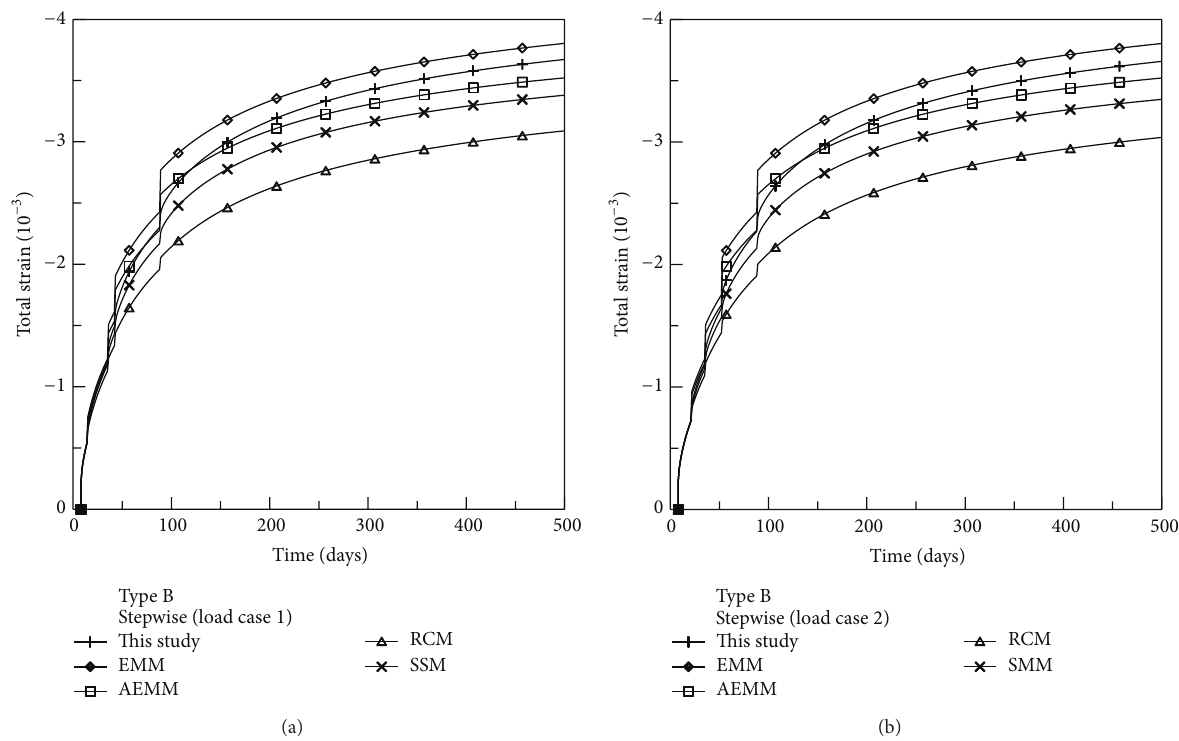
Figure 13: Extended predictions and comparison of the total strain by the five creep models (type B test): (a) load case 1 and (b) load case 2.